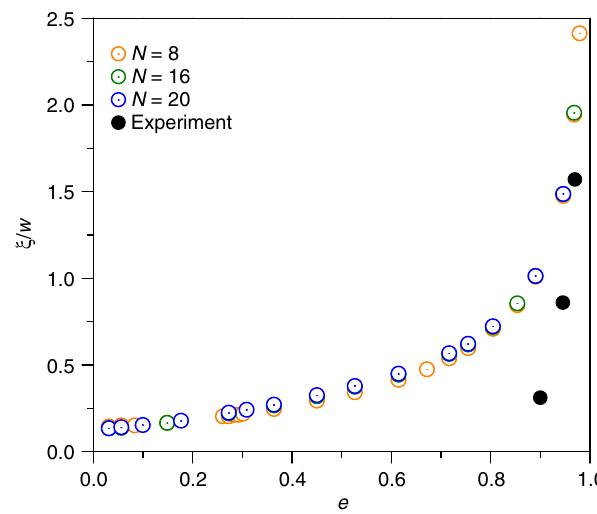
Fig. 5 Separatrix distance vs. e . Normalized vortex separatrix distance from the cavity edge, ξ / w , as a function of eccentricity ( e ), obtained from experiments (solid symbols) and from numerics by solving bi-harmonic stream function of order N = 8, 16, and 20 (open